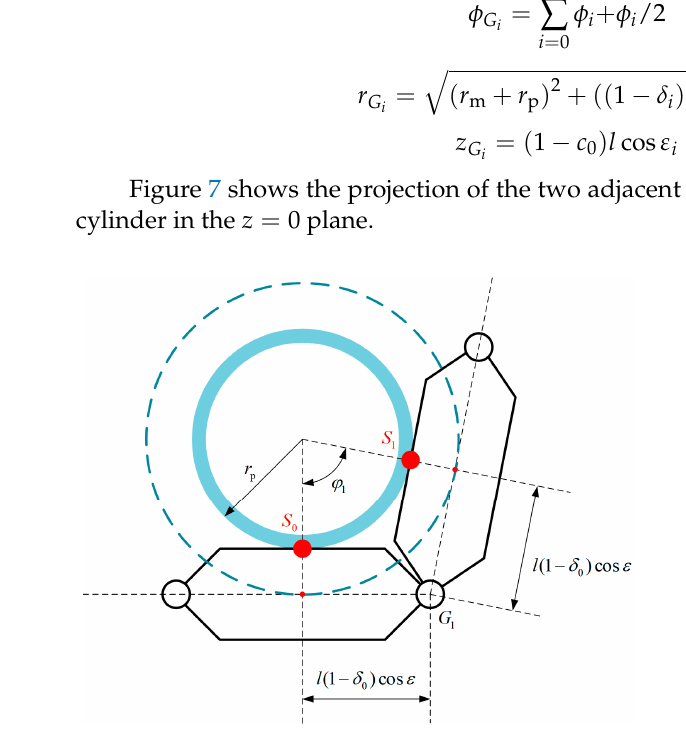
Figure 7. The contact between two adjacent modules and the cylinder.